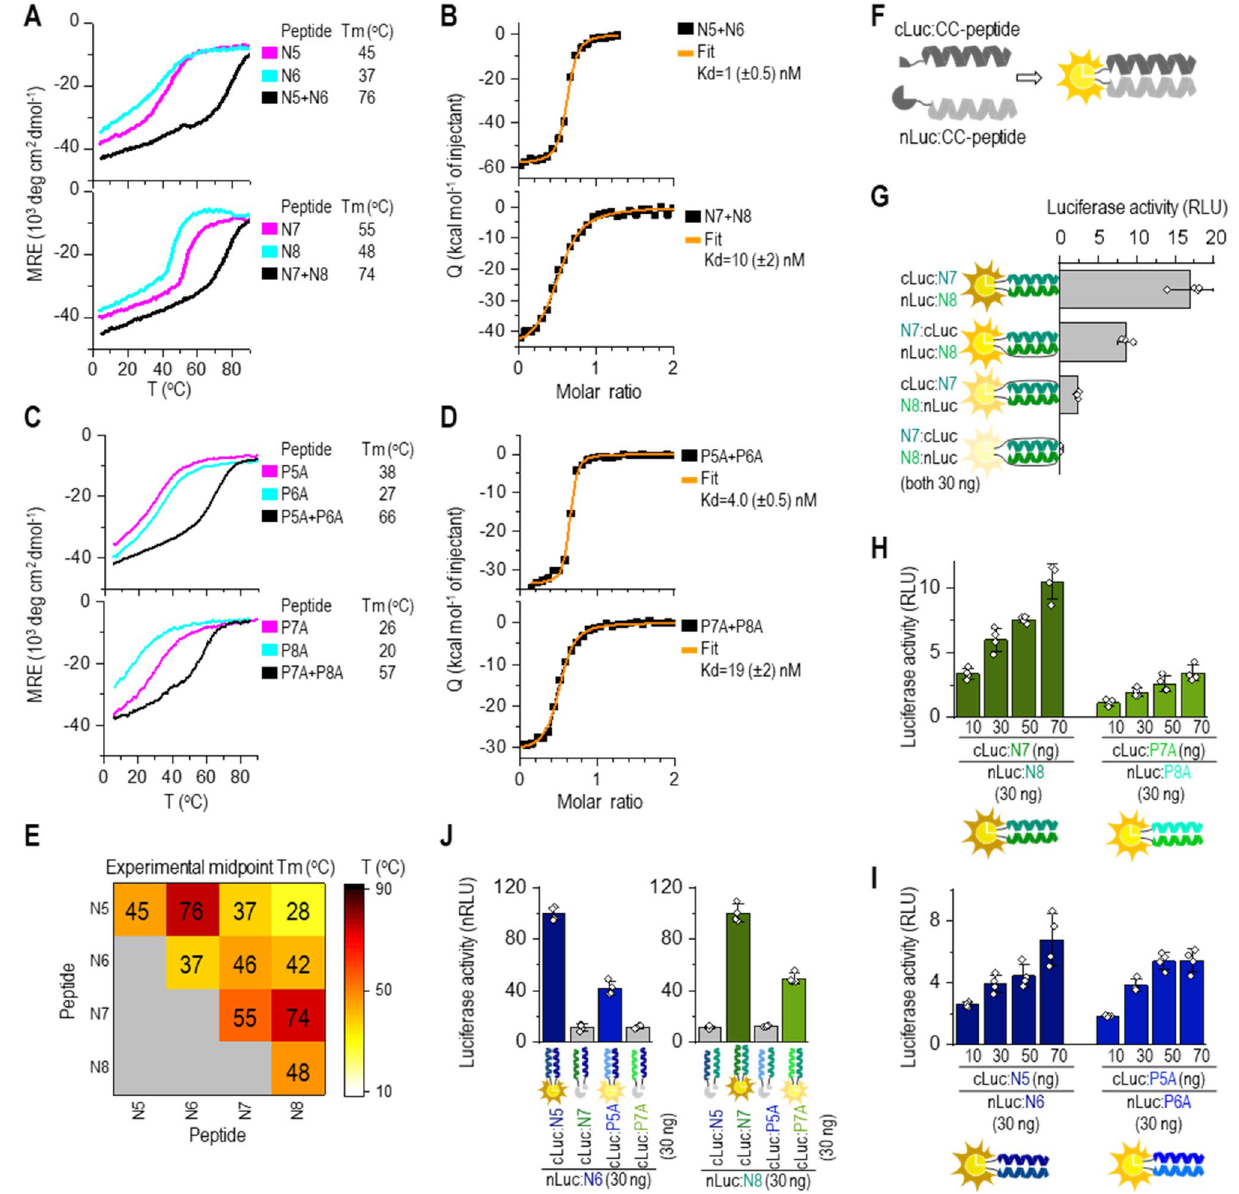
Figure 1. Orthogonal CC peptide pairs with K d in the nanomolar range based on modifications at the b , c , and f sites. ( A , C ) Thermal denaturation profiles of peptides (40 µM; magenta and cyan) and CCs (20 µM each peptide; black) monitored by a CD signal at 222 nm. The midpoint Tm was calculated based on thermodynamic model fit 35 . ( B , D ) Isothermal titration calorimetry (ITC) analysis of the binding affinity of designated CC peptide pairs. The binding isotherms of heat release per injection are depicted as a function of the increasing peptide-to-peptide molar ratio. The dissociation constant, K dITC , was calculated using the two-state dimer association model. ( E ) Heat map of the matrix of the calculated midpoint Tm from thermal denaturation scans of all peptide combinations. ( F ) Scheme of reconstitution of CC-split luciferase managed by a CC-forming peptide pair. ( G ) Luciferase activity of reconstituted CC-split luciferase in HEK293T measured 48 h after transfection of HEK293T cells with a plasmid expressing a combination of nLuc tethered to N8 (30 ng) and cLuc tethered to N7 peptide (30 ng). ( H , I ) Luciferase activity determined 48 h after transformation of HEK293T cells with plasmids expressing nLuc:N8 or nluc:N6 (30 ng); and cLuc tethered to N7 or P7A or cLuc tethered to N5 and P5A (10–70 ng). ( J ) Orthogonality of designed N peptide set in HEK293T cells by co-transfection of the nLuc:N8 or nLuc:N6 fusion encoding plasmid (30 ng), and cLuc:CC (CC stands for N5, P5A, N7, P7A) (30 ng). Reconstituted luciferase activity was measured 48 h after transfection. Amounts of plasmids are indicated in Table S2. The values ( G-J ) represent the means (± s.d.) from four independent cell cultures, individually transfected with the same mixture of plasmids, and are representative of two independent